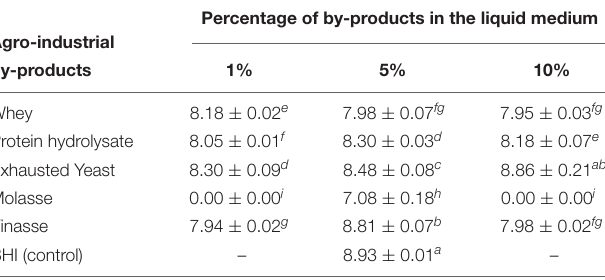
Values represent the means ± SD of three replicates. Different letters indicate significant differences (P <